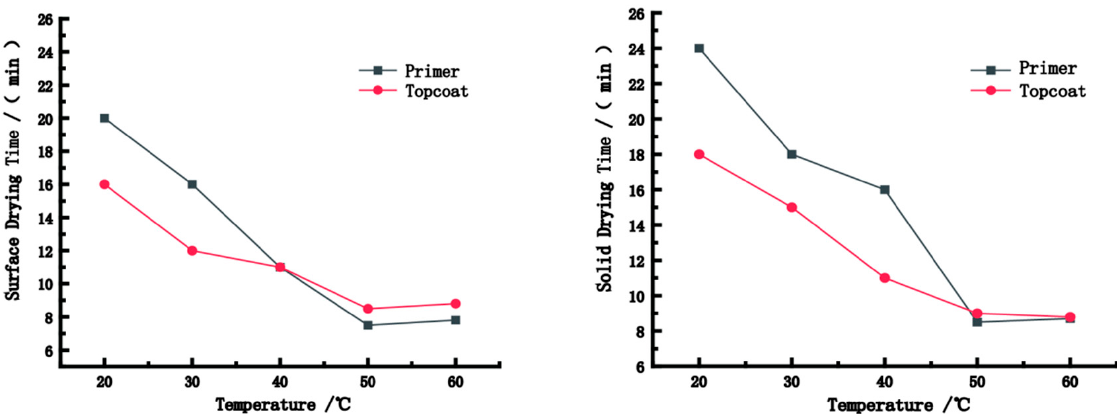
Figure 2. The surface and solid drying time of the paint films at different temperatures.